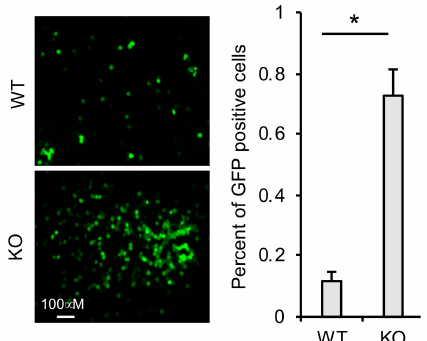
Figure 6. TRIM41 restricts incoming VSV nucleocapsids. TRIM41 wild type and knockout cells were infected with 1 MOI of VSV-GFP for 1 h. Then, cells were washed with PBS for two times to remove the unattached viruses. The neutralizing anti-VSV antibodies were added into the medium to prevent new infection. After 6 h, GFP positive cells were counted. The percentage of GFP-positive cells is summarized in the right graph. An asterisk indicates p <